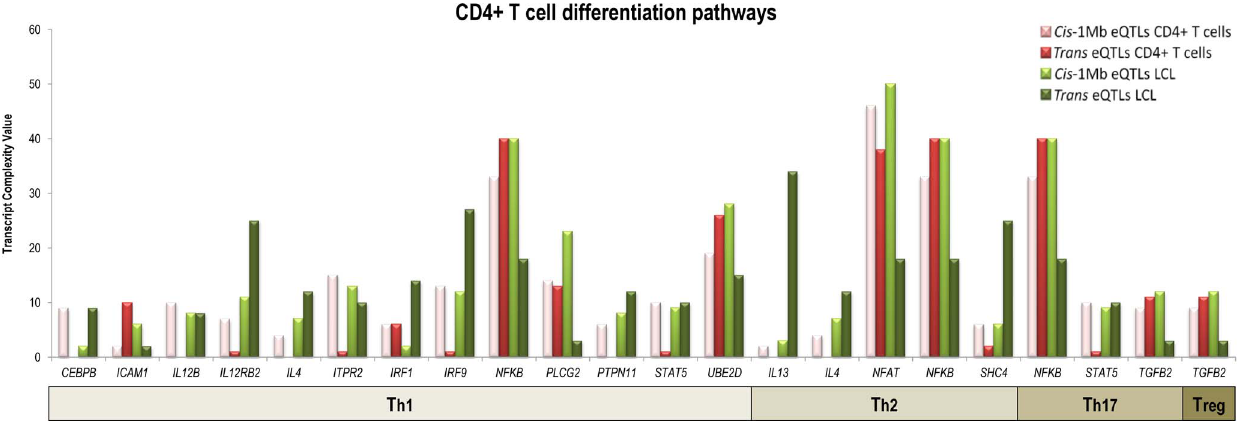
Figure 5. Transcript Complexity Value analysis of T cell differentiation genes. The type and quantity of significant eQTLs in RA CD4 + T cells and LCL cells are compared in the genes from the Th1, Th2, Th17 and Treg differentiation pathways. Only those genes showing a significantly different genomic regulation profile (P , 0.05) are shown.